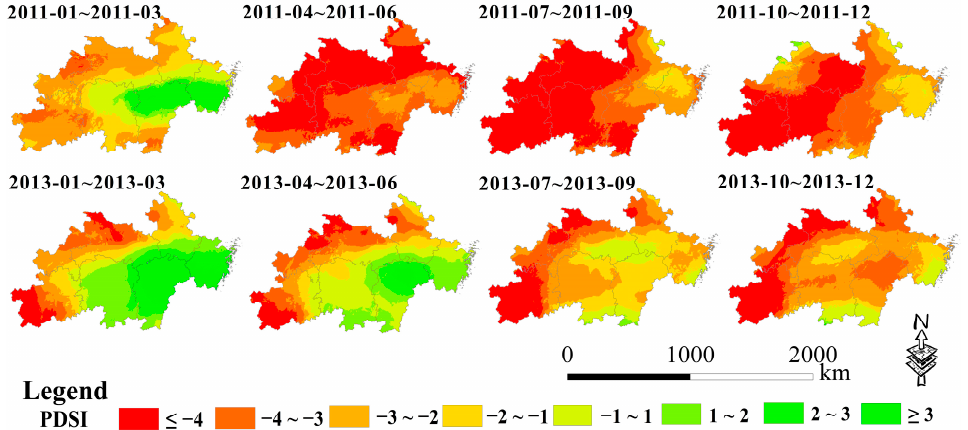
Figure 7. Spatial distributions of 3-month averages of the PDSI in the middle and lower reaches of the Yangtze River in China in 2011 and 2013.